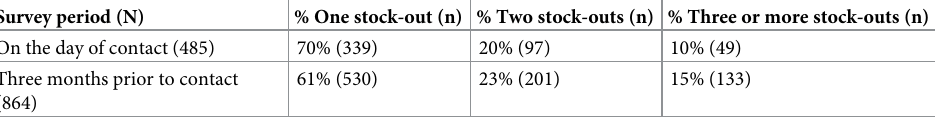
Table 4. Percentage of facilities reporting stock-outs with one, two or three or more stock-outs reported on the day of contact and in the three months prior to contact. Survey period